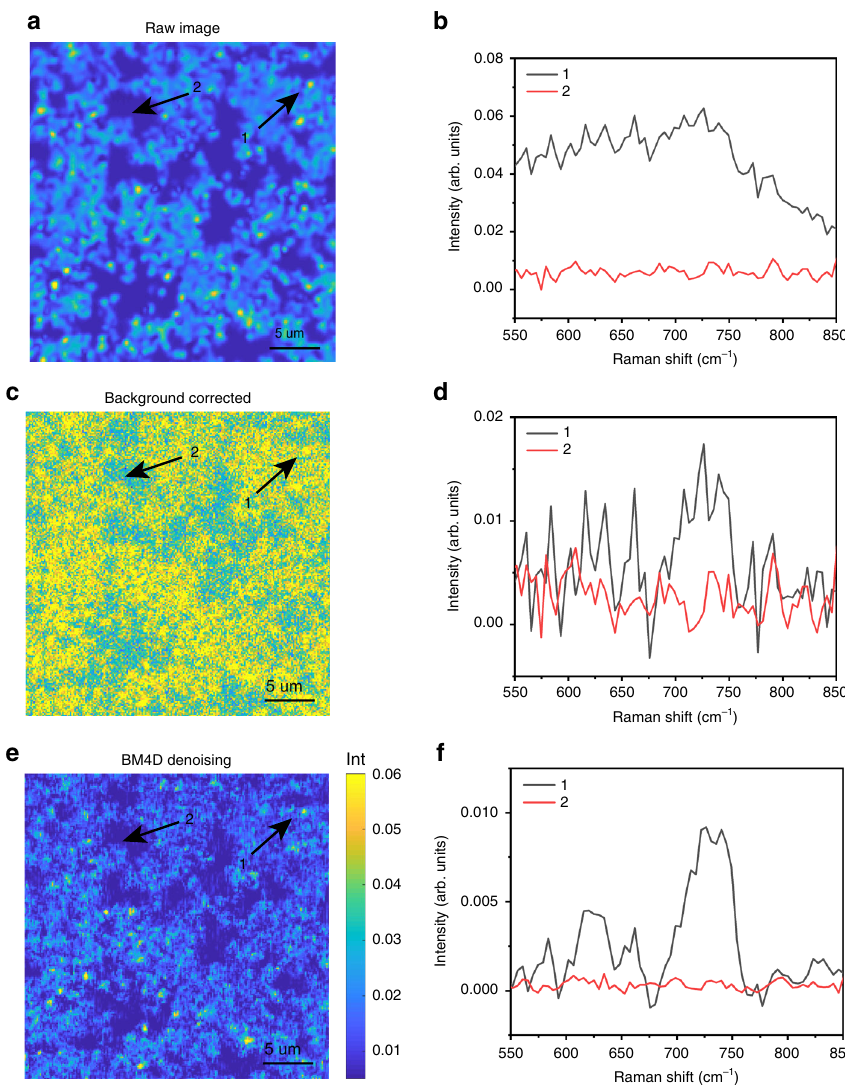
Fig. 2 Single-pixel PESRS. a The raw PESRS image of aggregated Au NPs substrate with adsorbed adenine. The color of each pixel represents the average total spectral channels intensity from each PESRS spectrum. b The raw single pixel spectra obtained from spot 1 and 2, which are indicated in a . c The PESRS image of adsorbed adenine on aggregated Au NPs substrate. The color of each pixel represents the peak area at 733 cm − 1 after background subtraction. d The background-removed single-pixel spectra obtained from spot 1 and 2 which are indicated in c . e The BM4D-denoised PESRS image of adsorbed adenine on aggregated Au NPs substrate. The color of each pixel represents the peak area at 733 cm − 1 after BM4D denoising and background subtraction. f The BM4D-denoised single-pixel spectra obtained from spot 1 and 2 which are indicated in e . Image area: 30 μ m × 30 μ